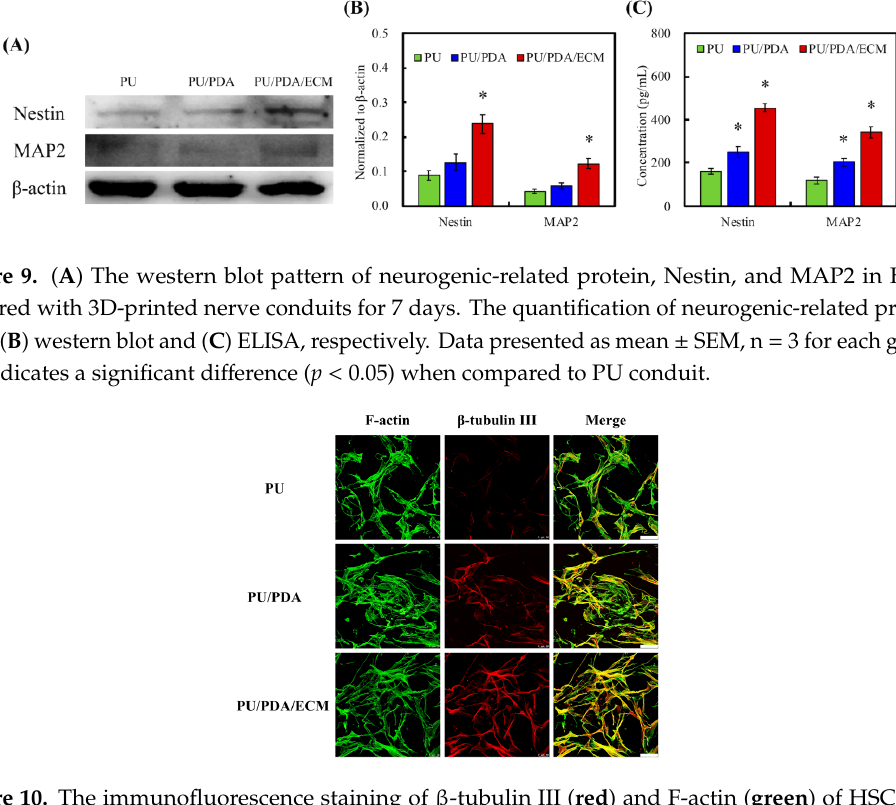
Figure 10. The immunofluorescence staining of β -tubulin III ( red ) and F-actin ( green ) of HSC cells grown on PU, PU/PDA, and PU/PDA/ECM conduits after cultured for 7 days.